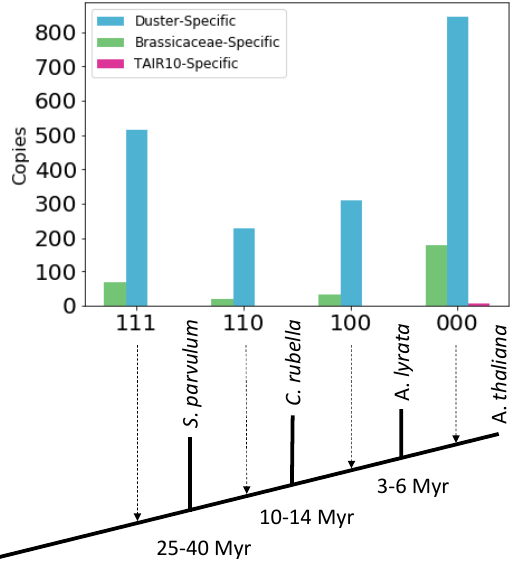
Figure 4 : Numbers of sequences conserved in orthologous positions between species. The three-digit code indi cates the species in which the sequences were present. A “1” indicates presence and a “0” absence, in A. lyrate (position 1), C. rubella (position 2), and S. parvulum (position 3).